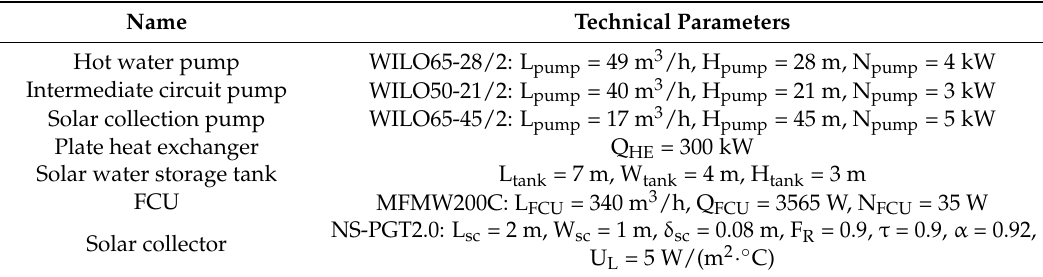
Figure 3. Solar water heat storage tank. Table 1. Technical parameters of the main units.